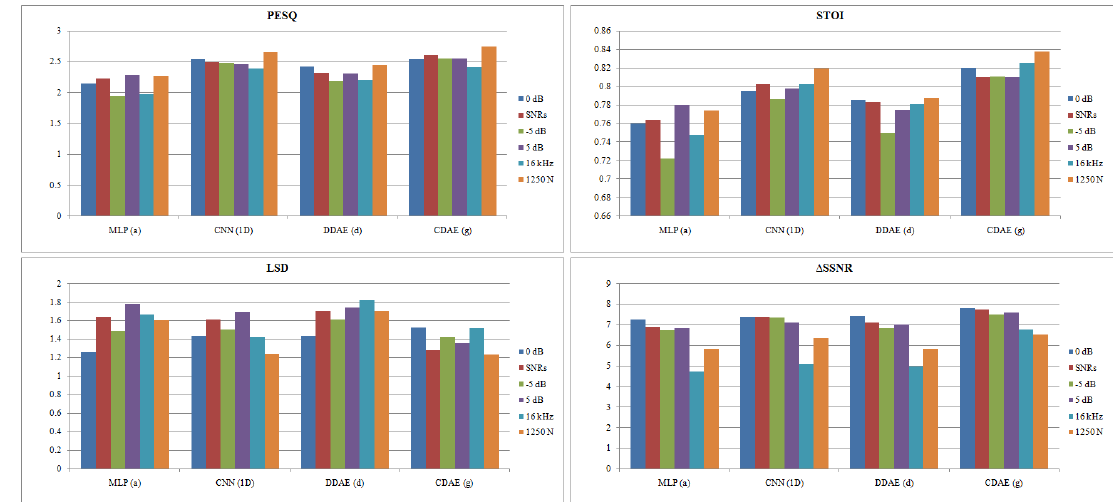
Figure 13. PESQ, STOI, LSD, and ∆ SSNR results when training the network at different SNR levels, when using sampling frequency 16 kHz instead of 8 kHz, and when increasing the number of noise environments to 1250 instead of